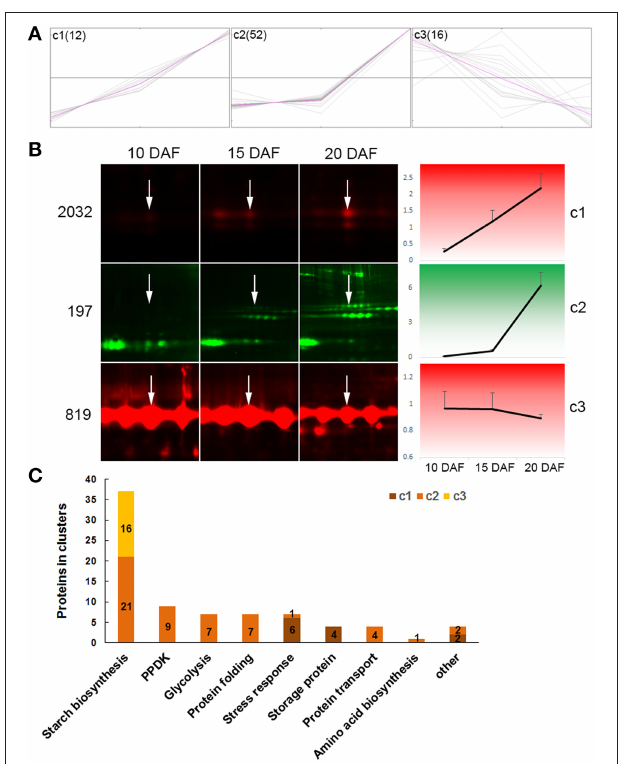
FIGURE 4 | Cluster analysis of differentially expressed proteins. Only proteins from one-protein containing spots were included. (A) Proteins were organized into 3 clusters with the MeV 4.9 software. Expression abundance of proteins were first normalized, then used in cluster analysis. Gray lines representing expression profiles of individual proteins in a cluster, and pink lines representing concentriods of each cluster. (B) Expression profiles of three protein spots as examples: spot 2032 for c1, spot 197 for c2, and spot 819 for c3. White arrows show the indicated spot in the distinct developmental stage. (C) Distribution of proteins from different function categories in the three